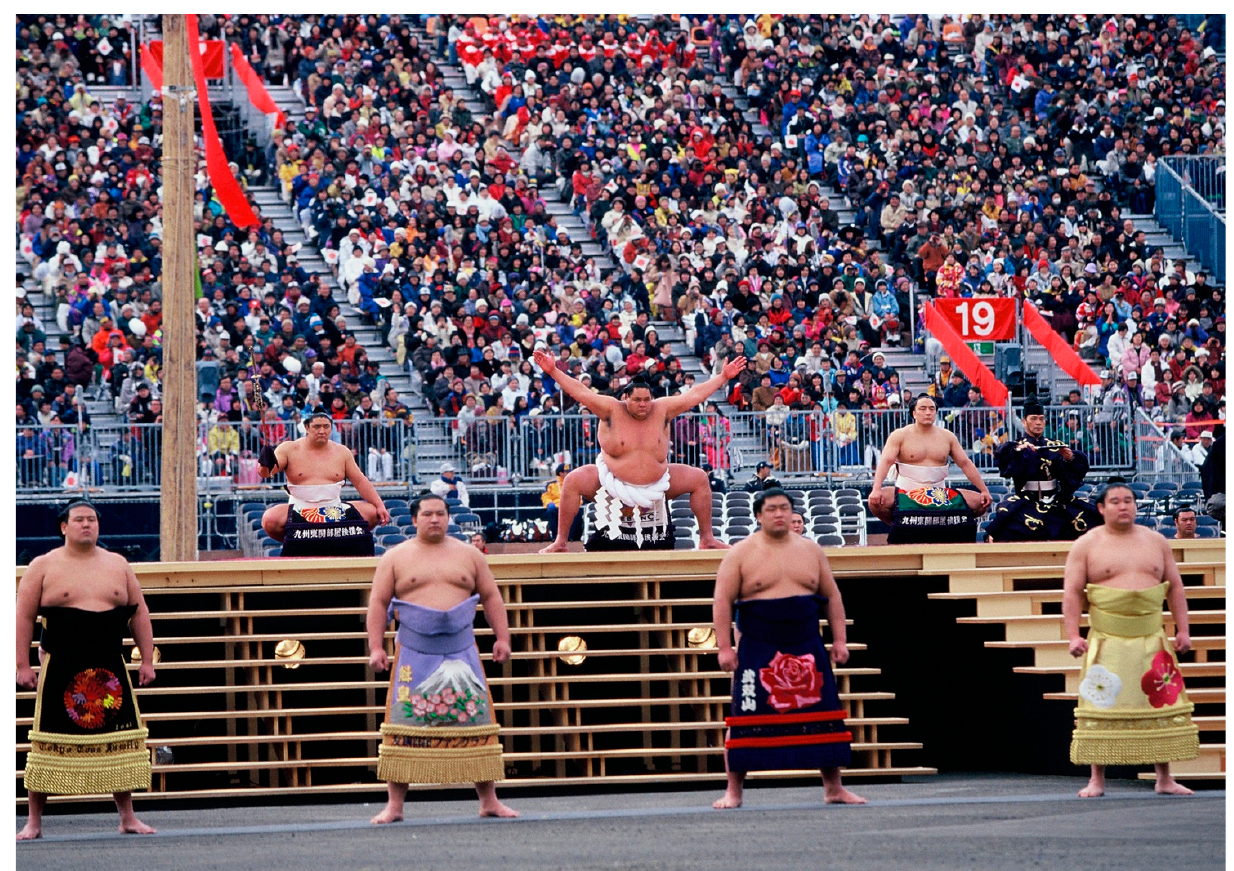
Figure 9. The yokozuna Akebono and professional sumo wrestlers performing at the opening ceremony of the XVIII Olympic Winter Games in Nagano, Japan, February 7, 1998. Reproduced with permission from Koji Aoki/AFLO SPORT; published by AFLO (image no. 4442718).